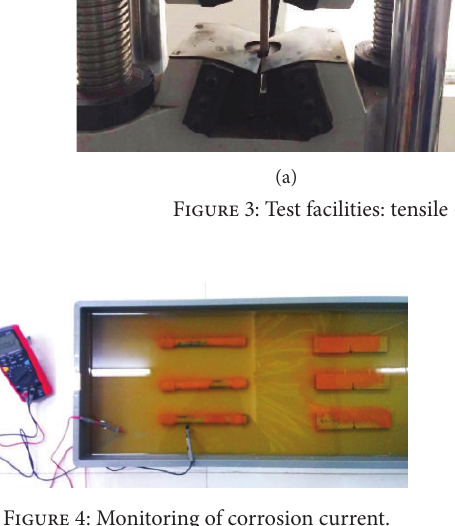
Figure 4: Monitoring of corrosion